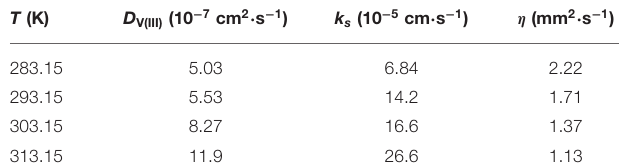
TABLE 4 | Rate constant of the reduction reaction ( k s ) and the diffusion coefficient ( D V(III) ) of V(III) at different temperatures.